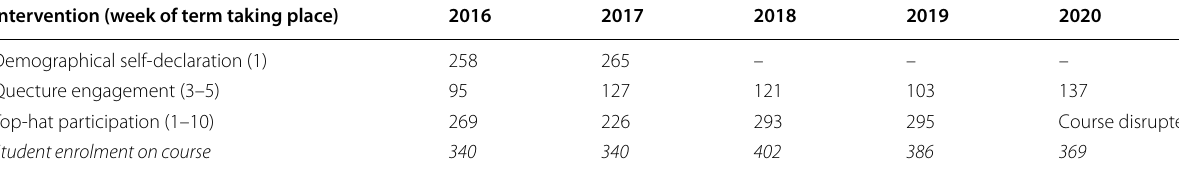
Table 1 Numbers of students taking part in voluntary interventions over 5 annual course iterations Intervention (week of term taking